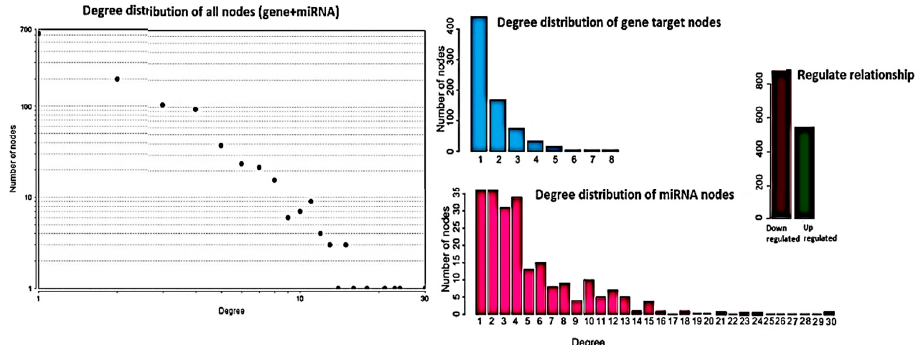
Figure 4. Topological features of the miRNA–target gene di ff erential regulatory network (MGDRN). The degrees of all nodes and miRNAs ranged from 1–30, and the degrees of messenger RNA (mRNA) ranged from 1–8. The total numbers of down- and upregulated relationships in the MGDRN were 879 and 541, respectively. Table 3. The topological features of the miRNA–gene target di ff erential regulatory network for each condition.